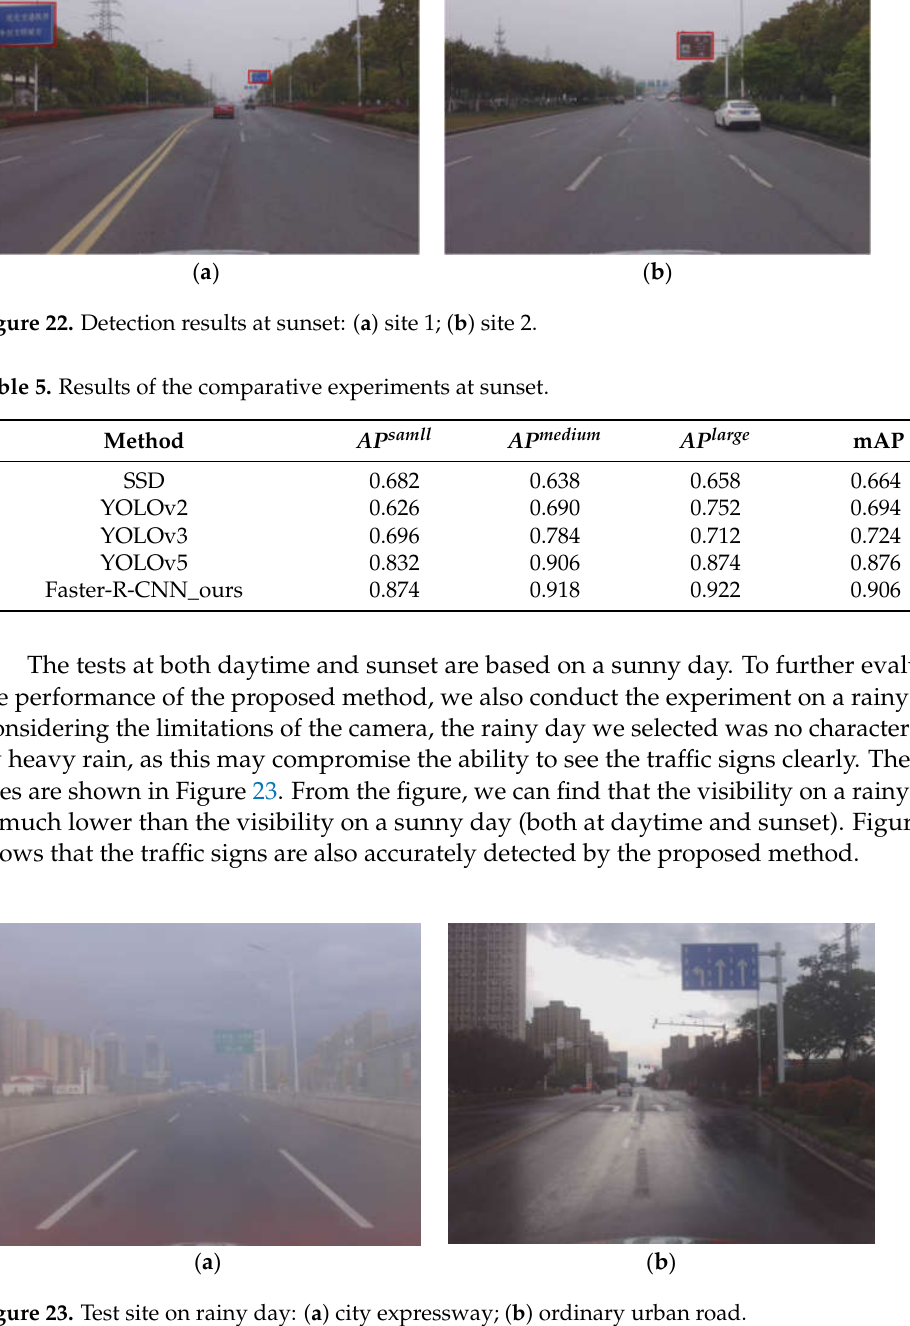
(b) Figure 21. Test site at sunset: ( a ) site 1; ( b ) site 2. Table 5. Results of the comparative experiments at sunset. Method